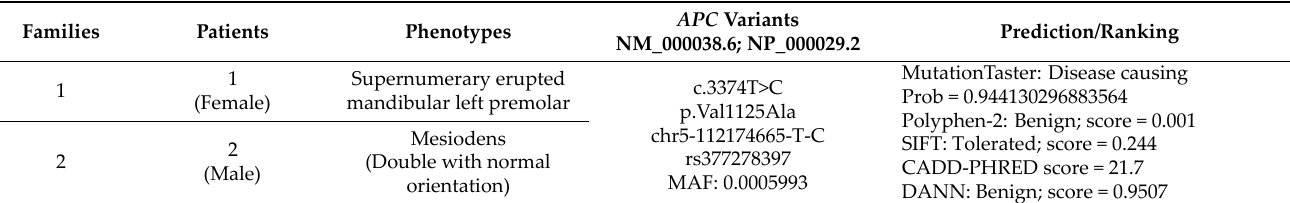
Table 1. Patients with APC variants and their dental